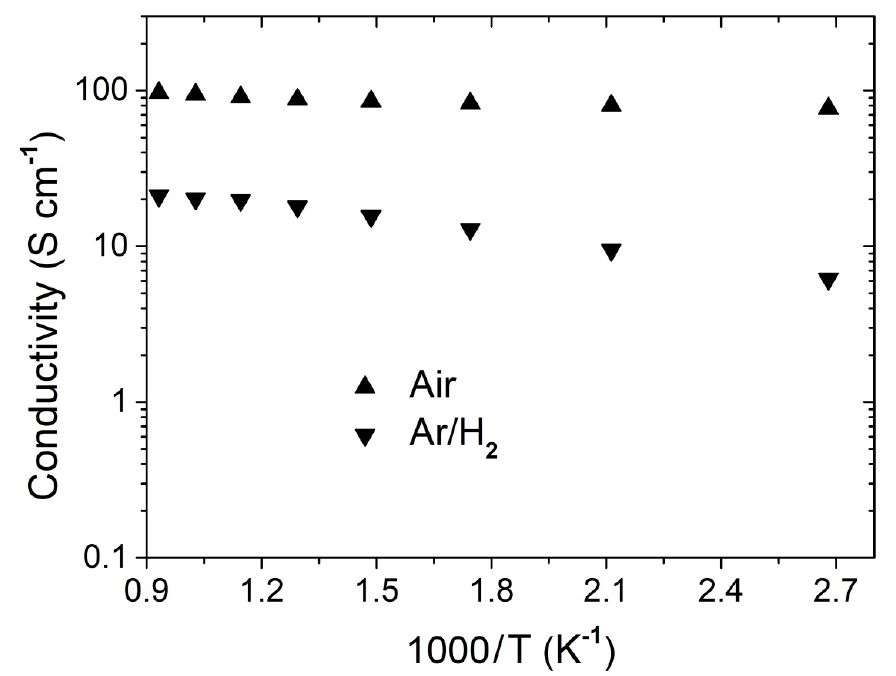
Figure 10. Temperature dependence of total conductivity of layered PBMO in air and argon.